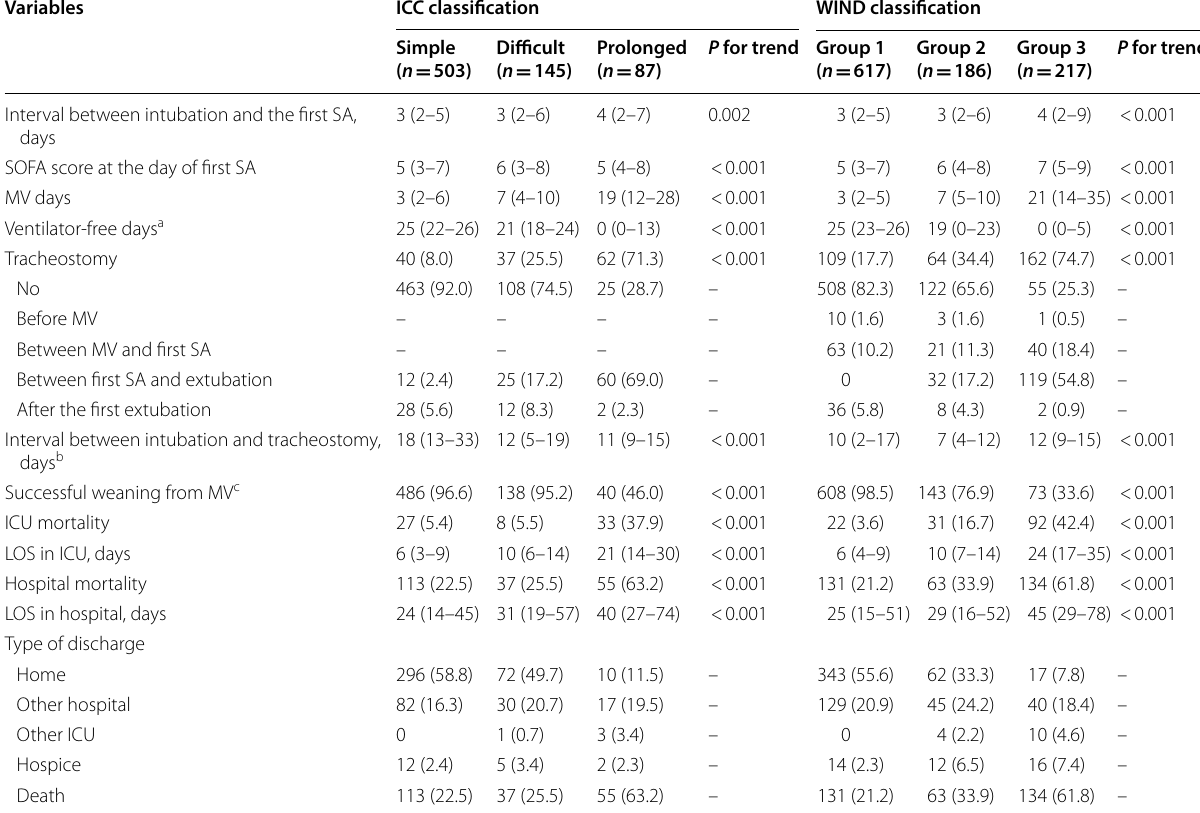
Table 5 Clinical outcomes according to ICC and WIND